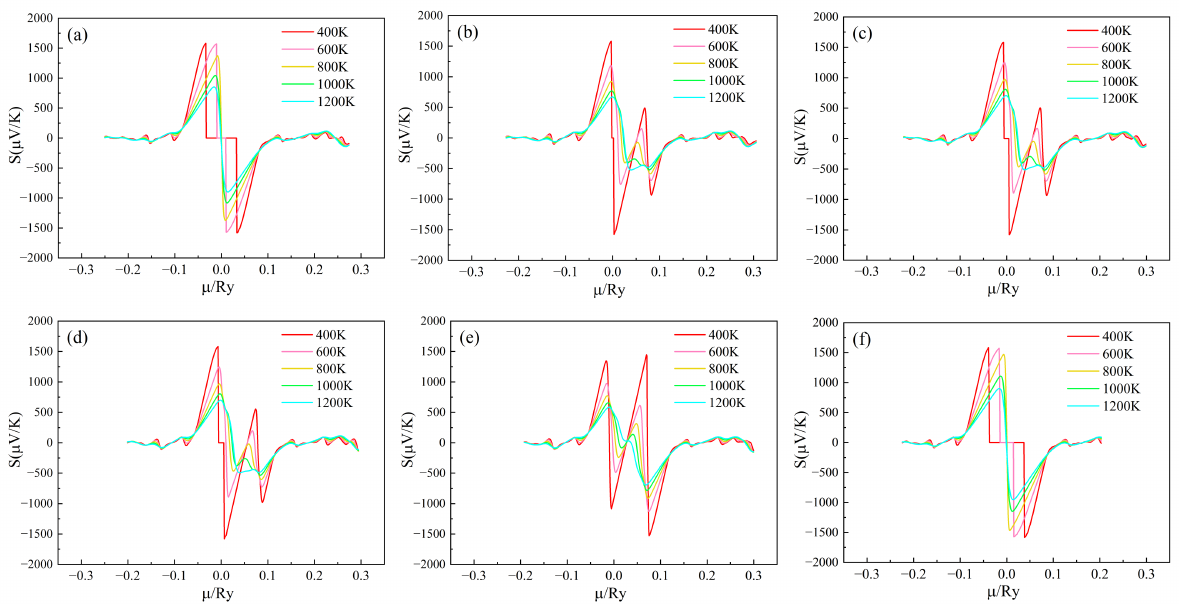
Figure 4. Chemical potential dependent of S of (Sr 0.889-x La 0.111 Bi x )TiO 2.963. ( a ) Sr 0.889 La 0.111 TiO 2.963; ( b ) Sr 0.852 La 0.111 Bi 0.037 TiO 2.963; ( c ) Sr 0.815 La 0.111 Bi 0.074 TiO 2.963; ( d ) Sr 0.778 La 0.111 Bi 0.111 TiO 2.963; ( e ) Sr 0.741 La 0.111 Bi 0.148 TiO 2.963; ( f ) Sr 0.815 La 0.185 TiO 2.963